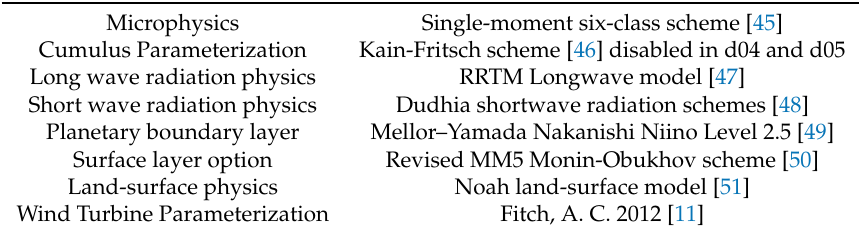
Table 1. The principal physical schemes used in the atmospheric